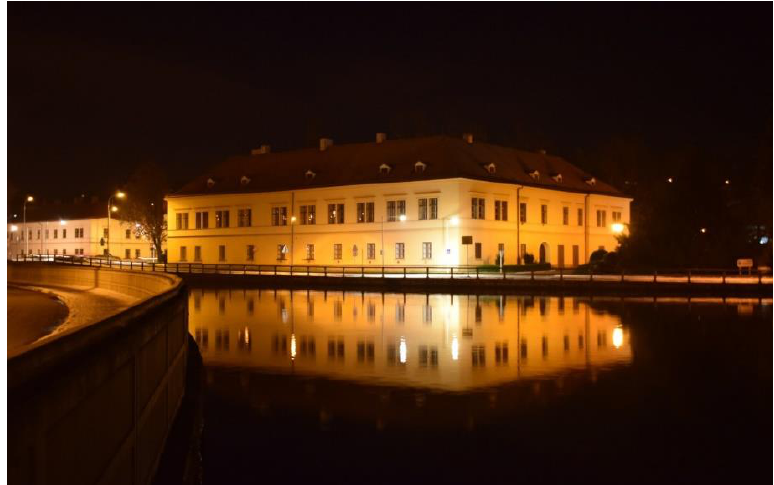
Figure 2. Choceň Chateau at night. Source: author, 2018. Figure 2. Choceˇn Chateau at night. Source: author,